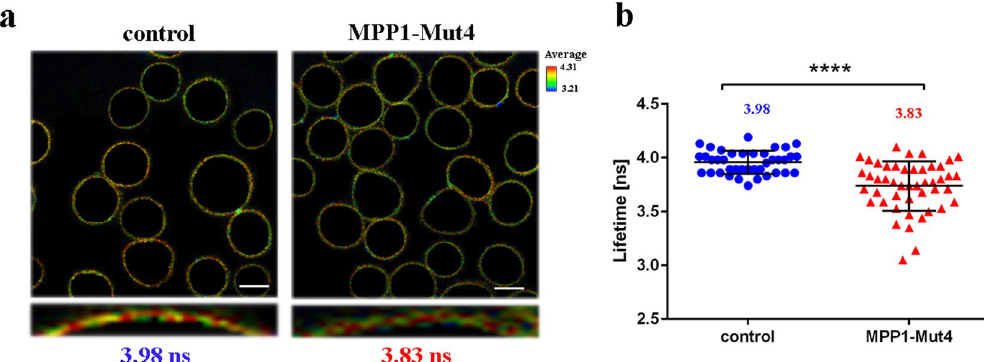
Figure 6. MPP1-Mut4 affects membrane order in HEL cells. Representative FLIM images ( a ) and quantitative analysis ( b ) of di-4 lifetime distribution collected from plasma membrane (ROI) of control (FLAG-transfected) and MPP1-Mut4-FLAG transfected HEL cells indicating significant (p < 0.0001) reduction in membrane order parameters after inhibition of endogenous MPP1-flotillin interactions. Each dot on a graph represents a single image of control (n = 38) and MPP1-Mut4-FLAG transfected cells (n = 42). Uncropped images, lifetime histograms as well as decay curves for representative images are shown in Fig. S8. Statistical analysis was performed using two-tailed unpaired t-test. Scale bar, 5 µm.